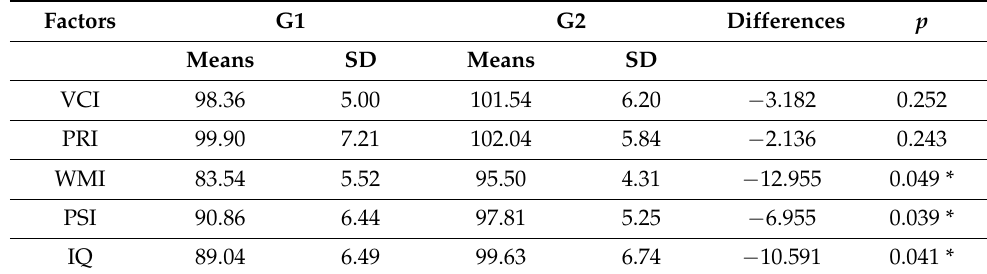
Table 2. Post hoc comparisons between Groups 1 and 2.